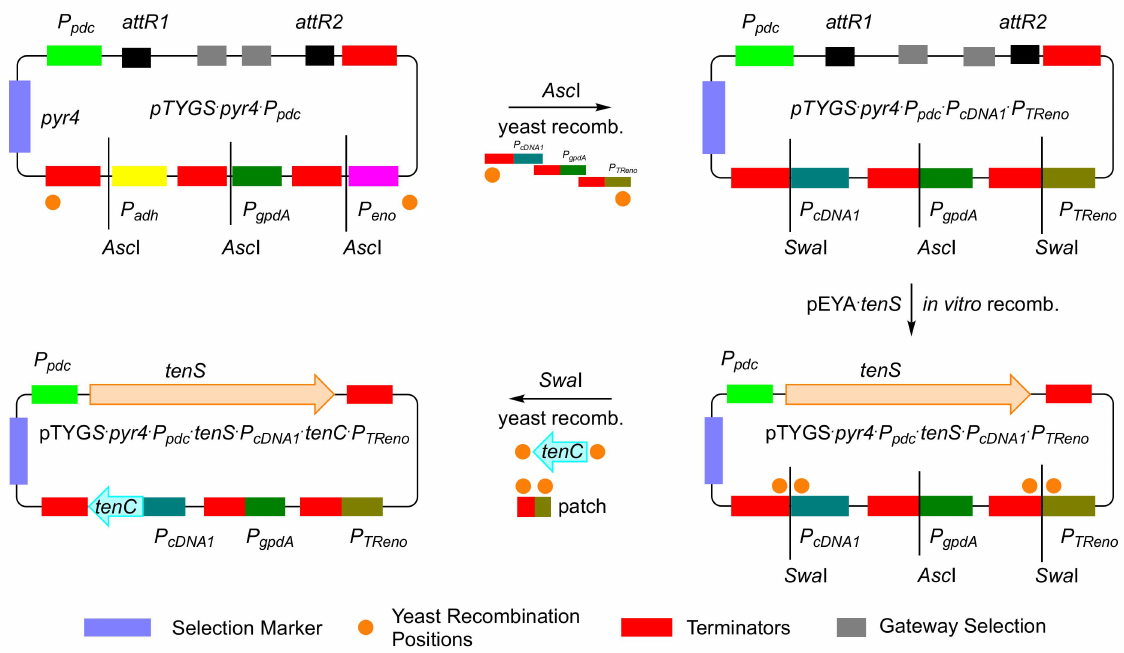
Figure 5. Construction of pTYGS · pyr4 · P pdc · P cDNA1 · P Treno and pTYGS · pyr4 · P pdc2 · tenS · P cDNA1 · tenC · P Treno